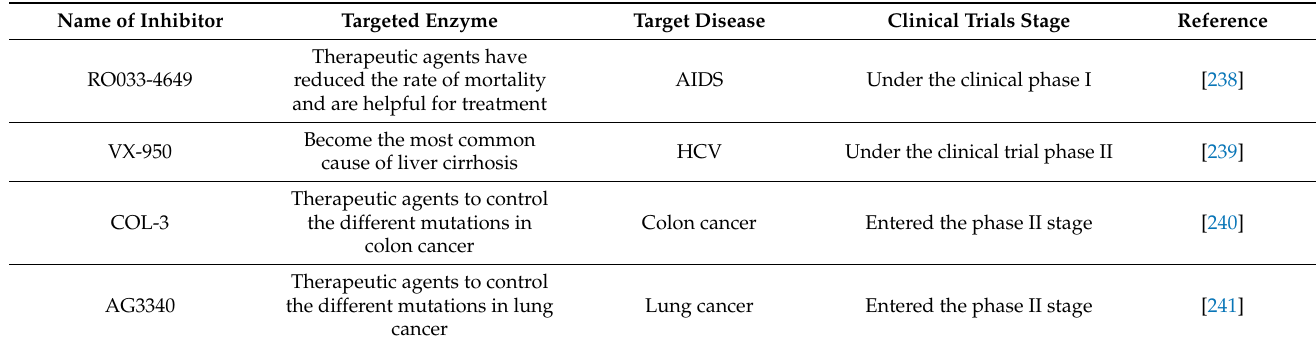
Table 6. Representation of protease inhibitors under clinical trials with the mechanism of action and therapeutic